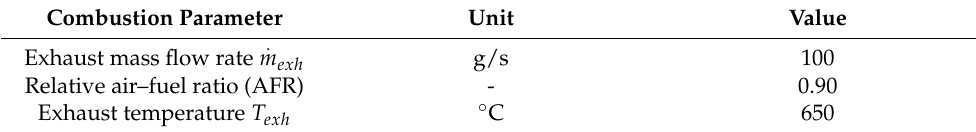
Table 8. Parameter set backpressure measurements (burner and ETB).